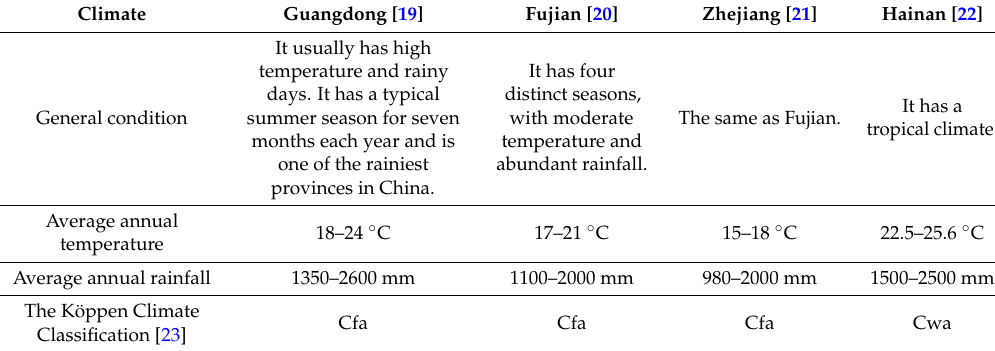
Table 1. The climate of the four